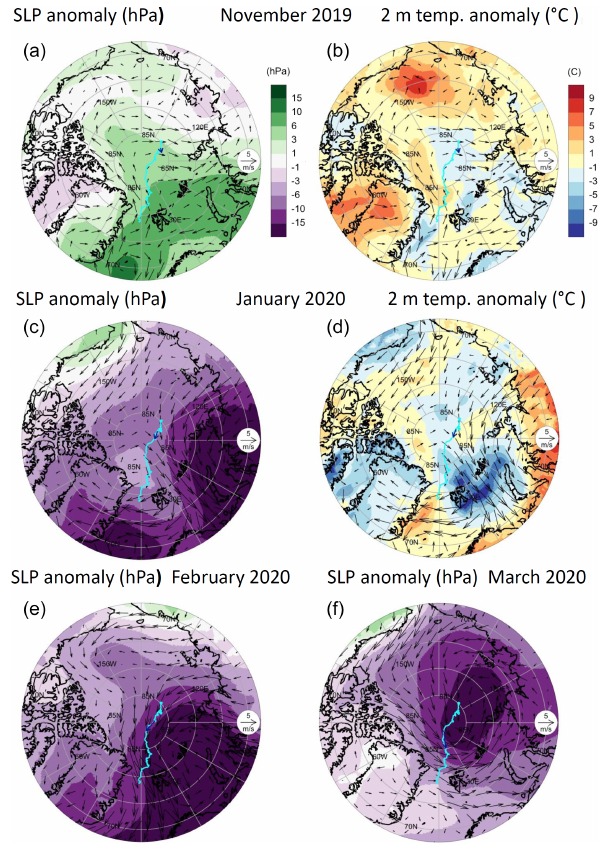
Figure 2. Sea-level pressure anomaly (hPa) (a, c, e) and 2m tem- perature anomaly (K) (b, d, f) for November 2019 (a, b) and Jan- uary 2020 (c, d) compared to the 2010–2019 climate mean based on ERA5. Sea-level pressure anomalies (hPa) for February 2020 (a, c, e) and March (b, d, f) 2020 (e, f) . Arrows display the direction and strength of 10m atmospheric winds. Cyan lines indicate the MO- SAiC ice floe track from October 2019 until August 2020. Small blue arrows indicate the location and drift of MOSAiC during the respective